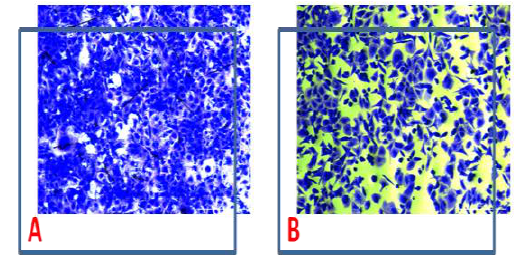
Figure 3. Cells of CAL-51; A: Effect of control. B: Effect of 100mcg/ml of compound [IV] at 72 hrs.